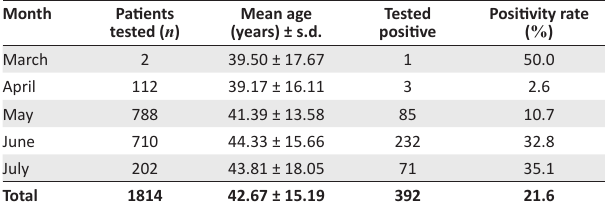
Male mortality Male recovery